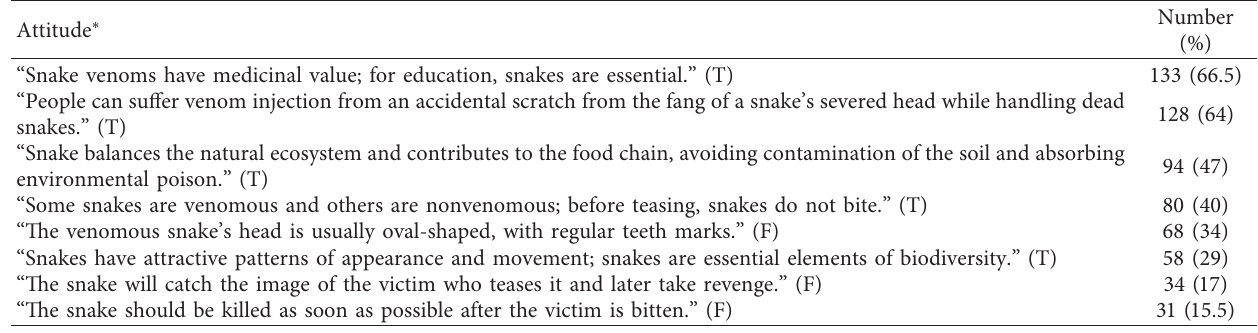
Table 8: Percentages of correct responses of nursing students to questions on attitude towards snakebite. Attitude ∗